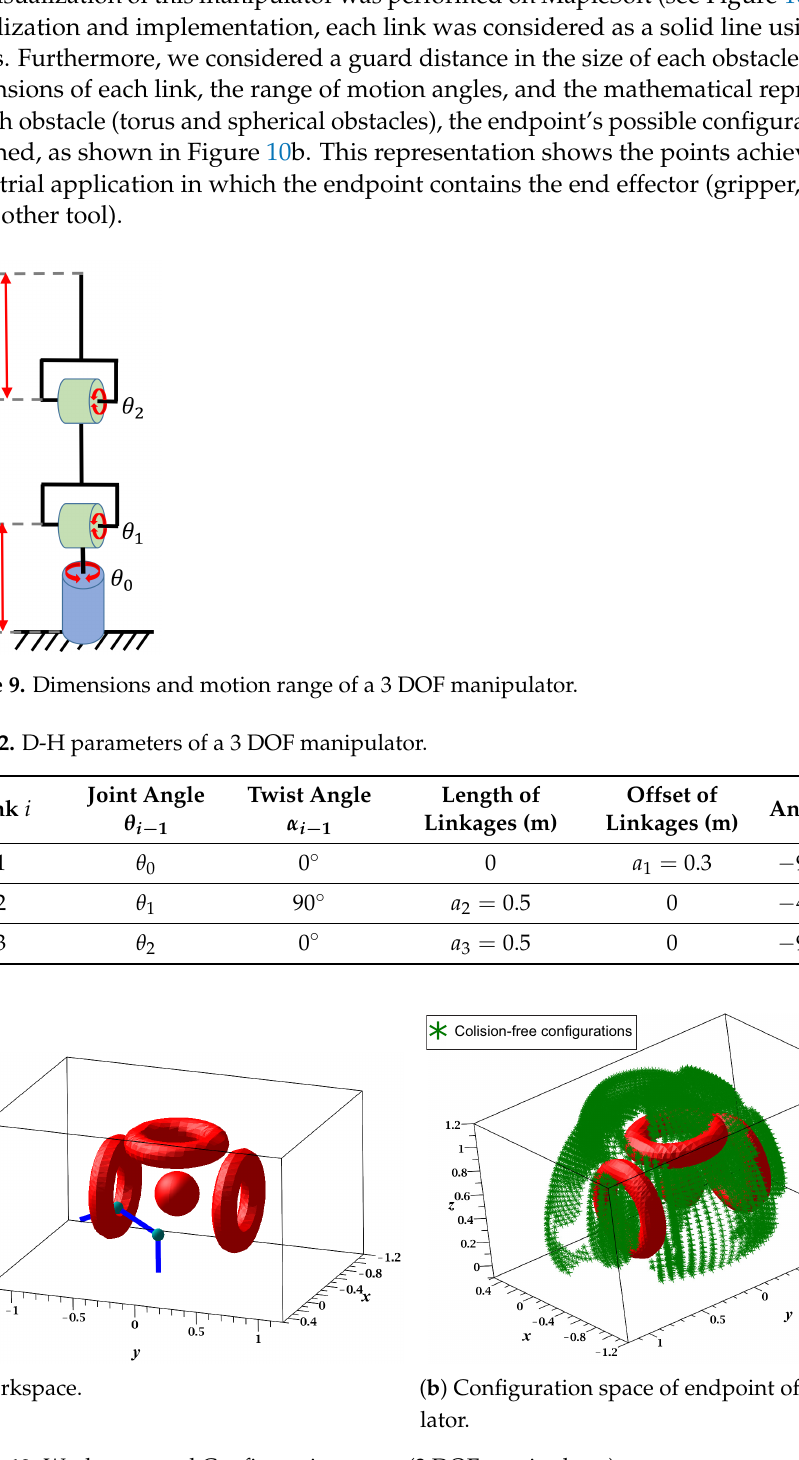
Figure 10. Workspace and Configuration space (3 DOF